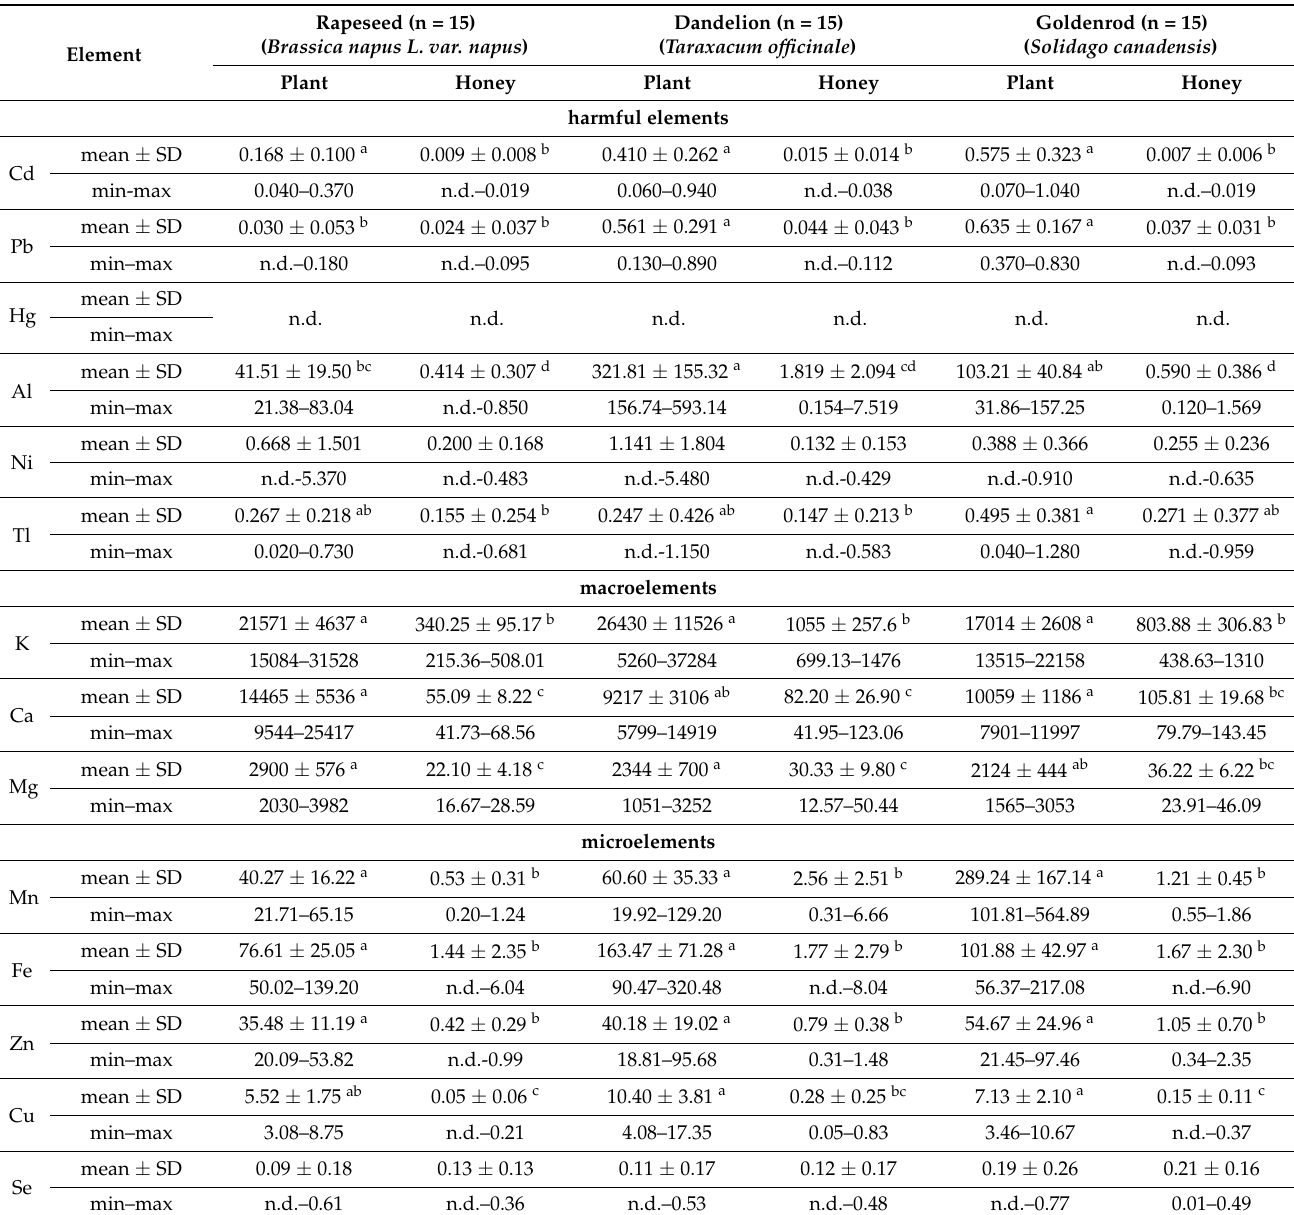
Table 1. The concentration of elements in tested melliferous plant inflorescences and honey samples